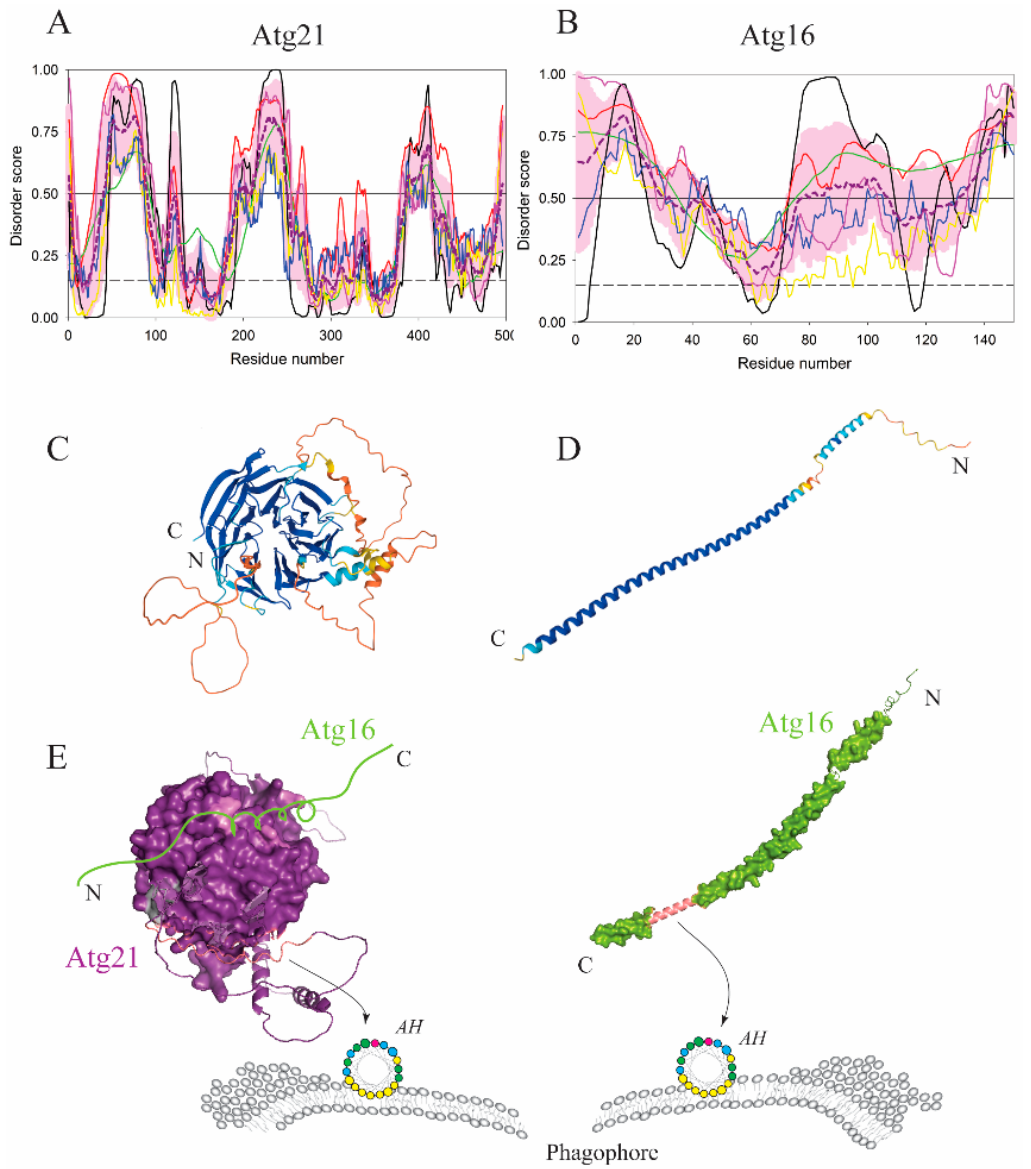
Figure 6. Atg21 and Atg16 in yeast utilize amphipathic helices for their association with the phagophore. ( A , B ) Disorder–order prediction from the amino acid sequence analysis of Atg21 and Atg16 from yeast, S. cerevisiae , showed that Atg21 is a hybrid protein with numerous disordered regions protruding from a folded architecture, whereas Atg16 is an intrinsically disordered protein in its monomeric form. According to the PONDR ® VLS2-based analysis, Atg21 and Atg16 are classified as highly disordered proteins, since their overall disorder contents amounted to 44.35% and 80.7%, respectively. ( C , D ) The AlphaFold model of Atg21 and Atg16 with color-coded modeling confidence. Very high confidence, blue; high confidence, cyan; medium confidence, yellow; low confidence, orange. Atg21 folds into an IDPR-enriched β -propeller, whereas Atg16 is a coiled-coil containing protein that undergoes several disorder-to-order transitions yielding mostly a helical structure upon dimerization and interaction with physiological binding partners. One monomer after these transitions is depicted. ( E ) Protein surface rendering of the Atg21 and Atg16 models from C and D. The membrane-binding segments that give rise to the amphipathic α -helices are highlighted in dark pink. Atg21 recruits the disordered Atg16 monomer to the phagophore, where Atg16 binds via its C-terminal AH.